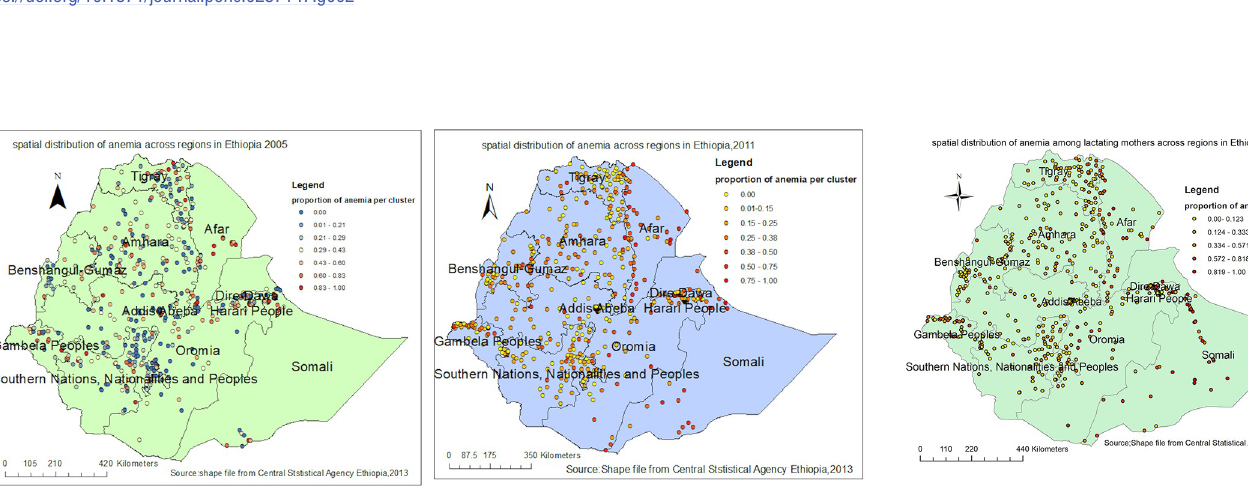
PLOS ONE | https://doi.org/10.1371/journal.pone.0237147 August 6, 2020 7 /